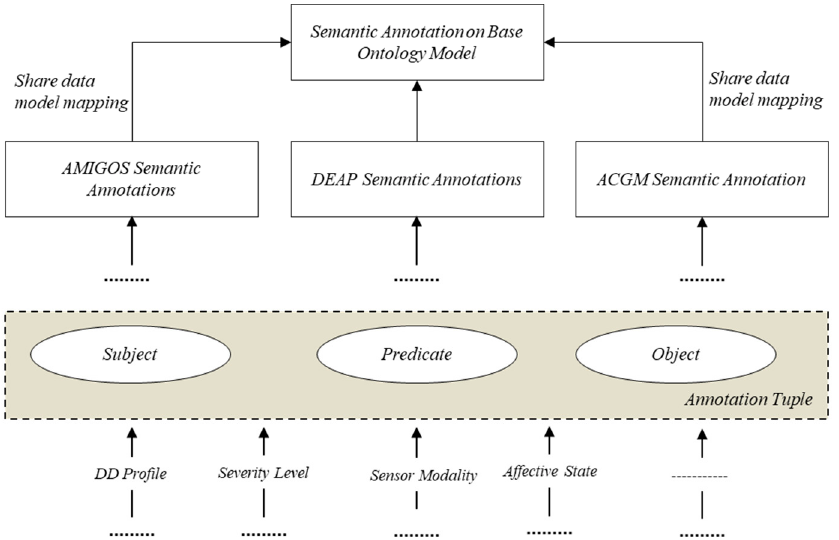
Figure 18. Semantic data mapping.